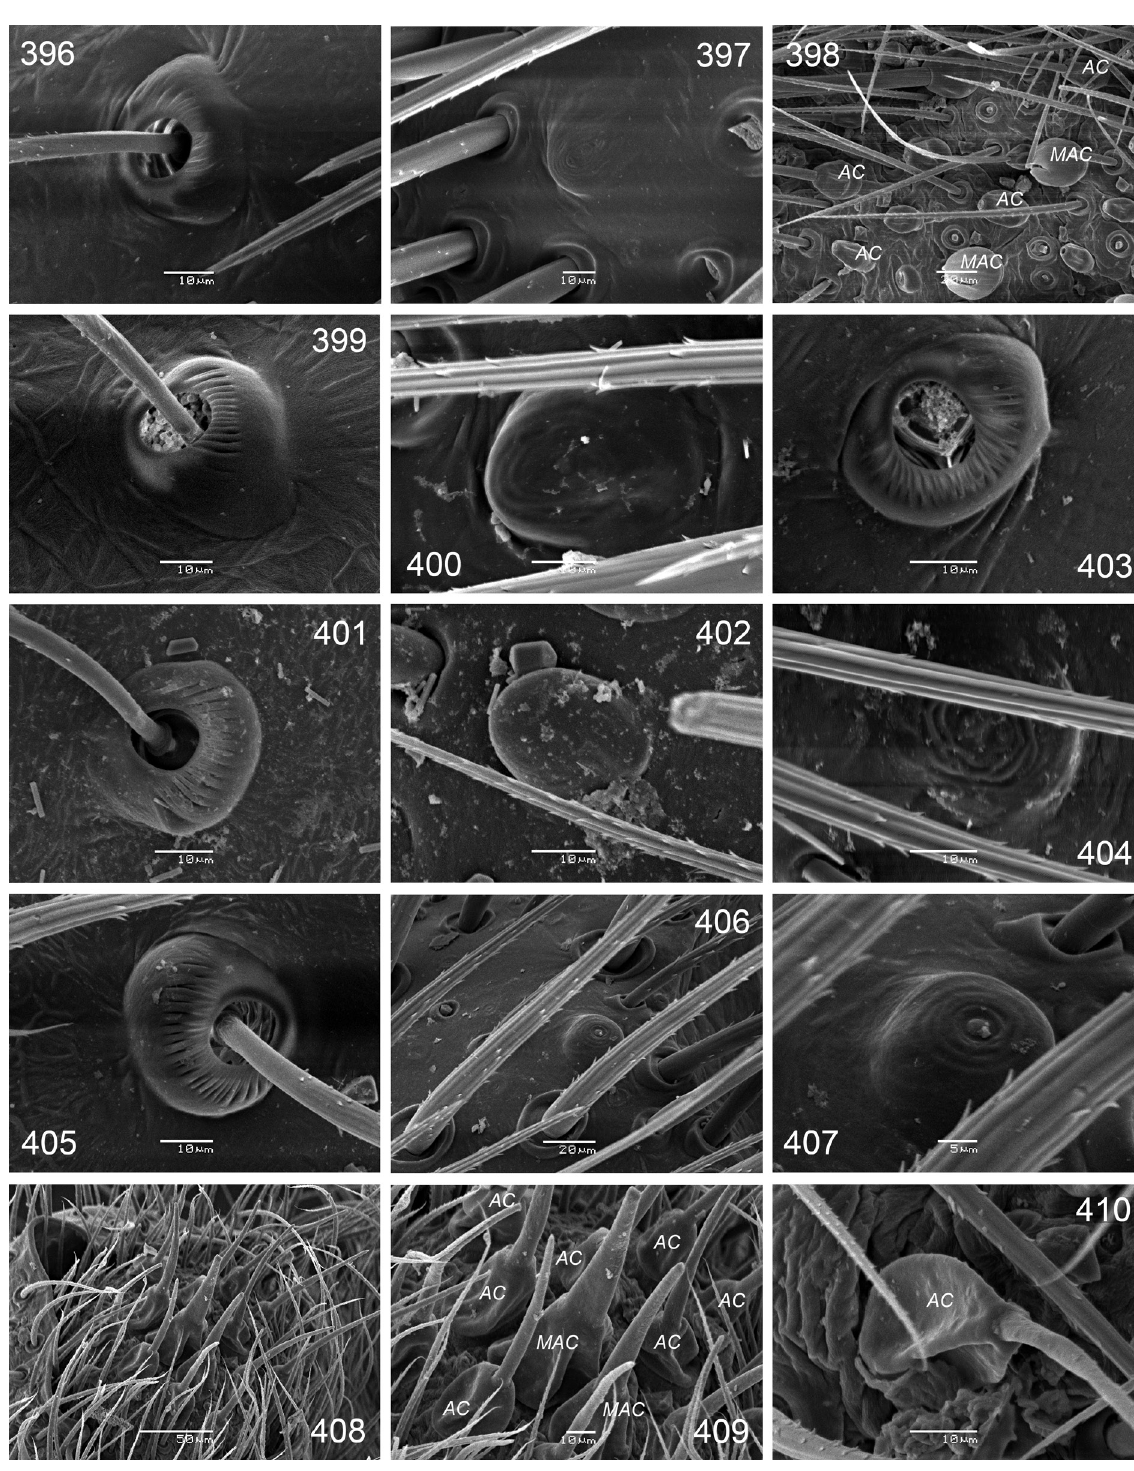
Figs 396–410. Mygalomorph spiders, members of Cyrtaucheniidae (396–402) and Nemesiidae